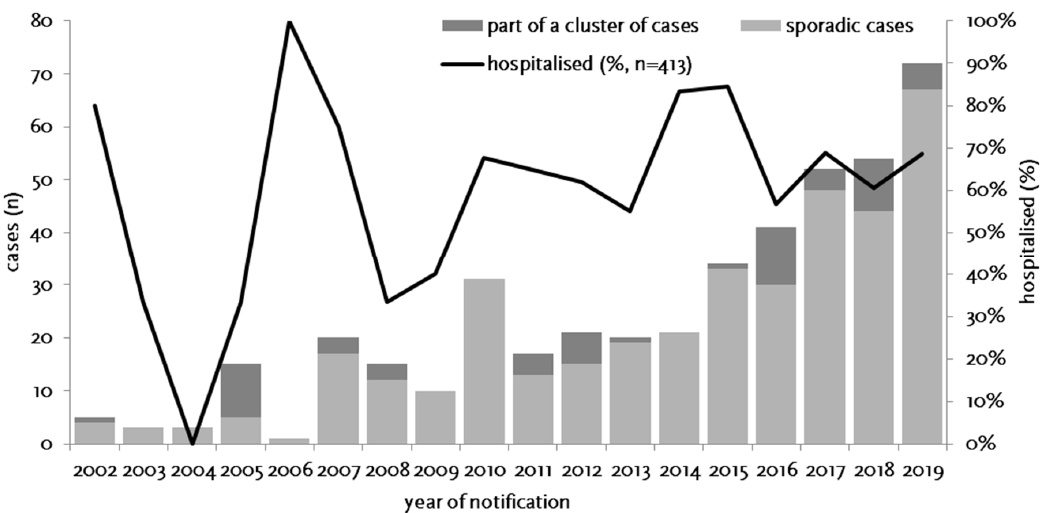
Figure 2. Notified cases of tularemia (sporadic and part of a cluster of cases, stacked bars) and proportion of hospitalized cases (line, second y -axis) by year of notification, Germany,